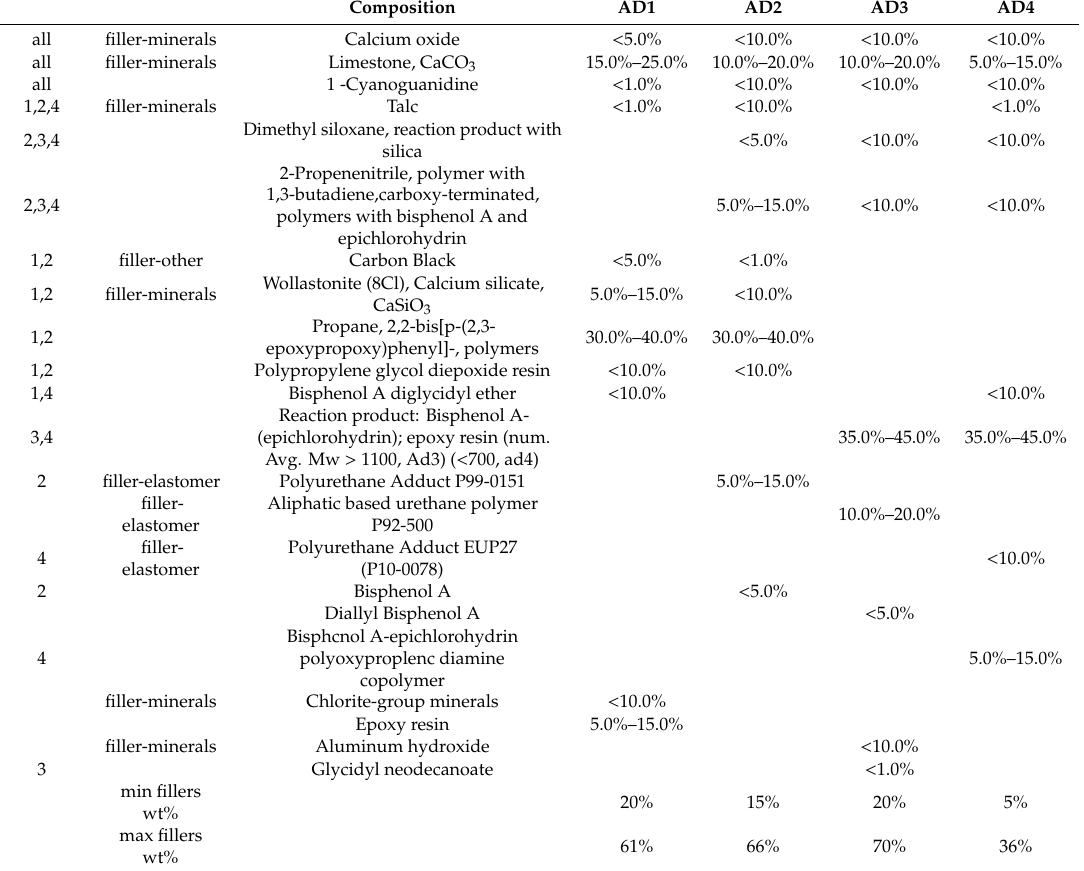
Table 1. Components of structural adhesives obtained from manufacturers’ material safety data sheets (MSDS) as provided by manufacturers and used during the first phase of the